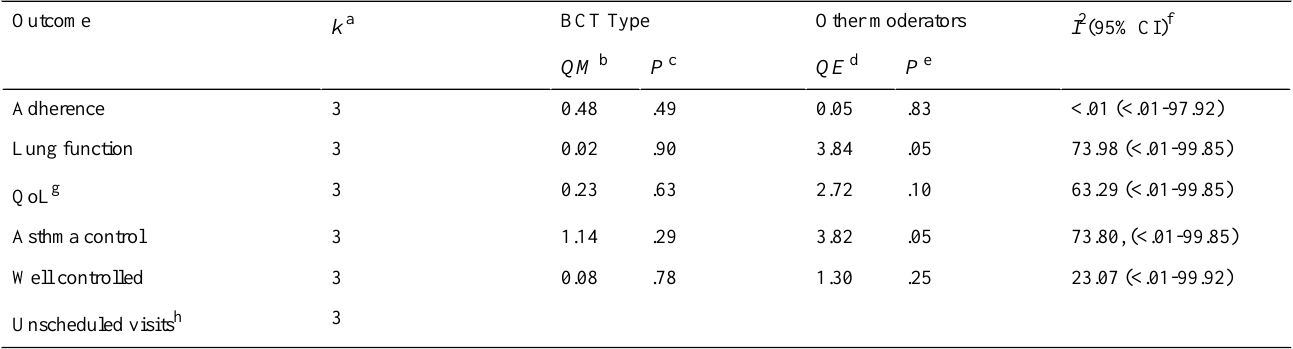
Table 7. Categorical moderation analysis for between group behavior change technique (BCT) type on relationship between mobile technology intervention, adherence, and clinical outcomes.